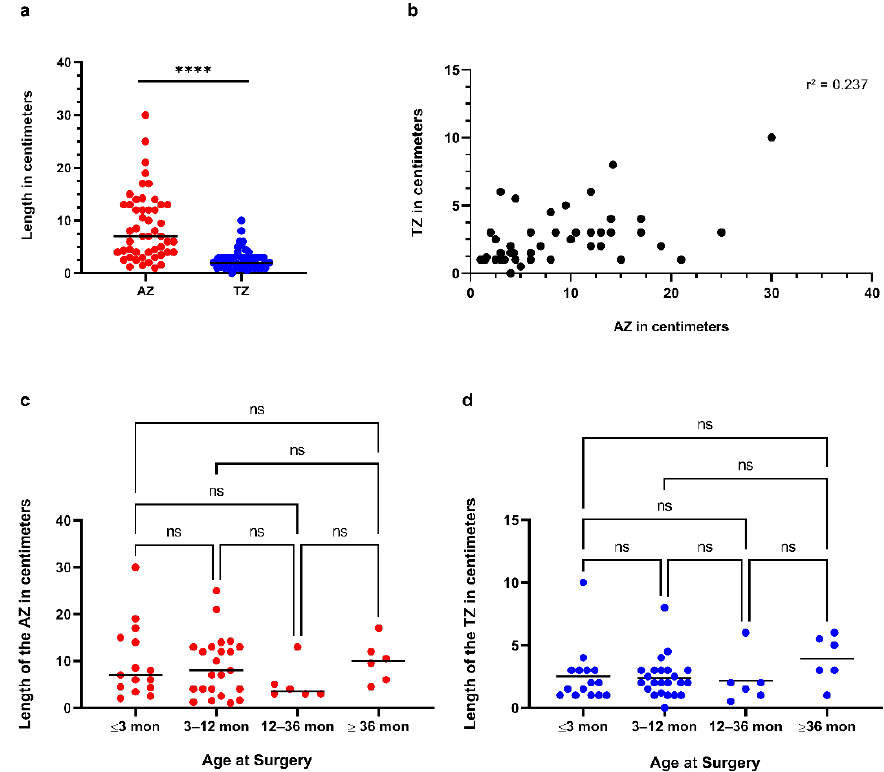
Figure 3. ( a ) Comparison between the transition and aganglionic zone lengths in centimetres of all patients showed a significant difference in length ( p < 0.0001, “****”) ( b ) The relationship between the aganglionic zone and transition zone indicates no or negligible correlation between the length of the age at surgery and length of the transition or aganglionic zone in centimetres, represented by an r 2 of 0.237. ( c,d ) A Kruskal – Wallis test between patients showed no significant difference in length and age at surgery.